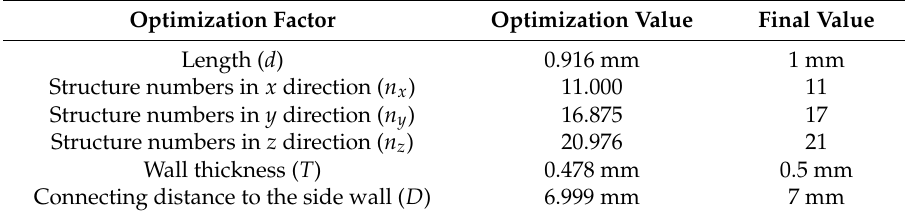
Table 11. Optimization and final value of storage tank structure